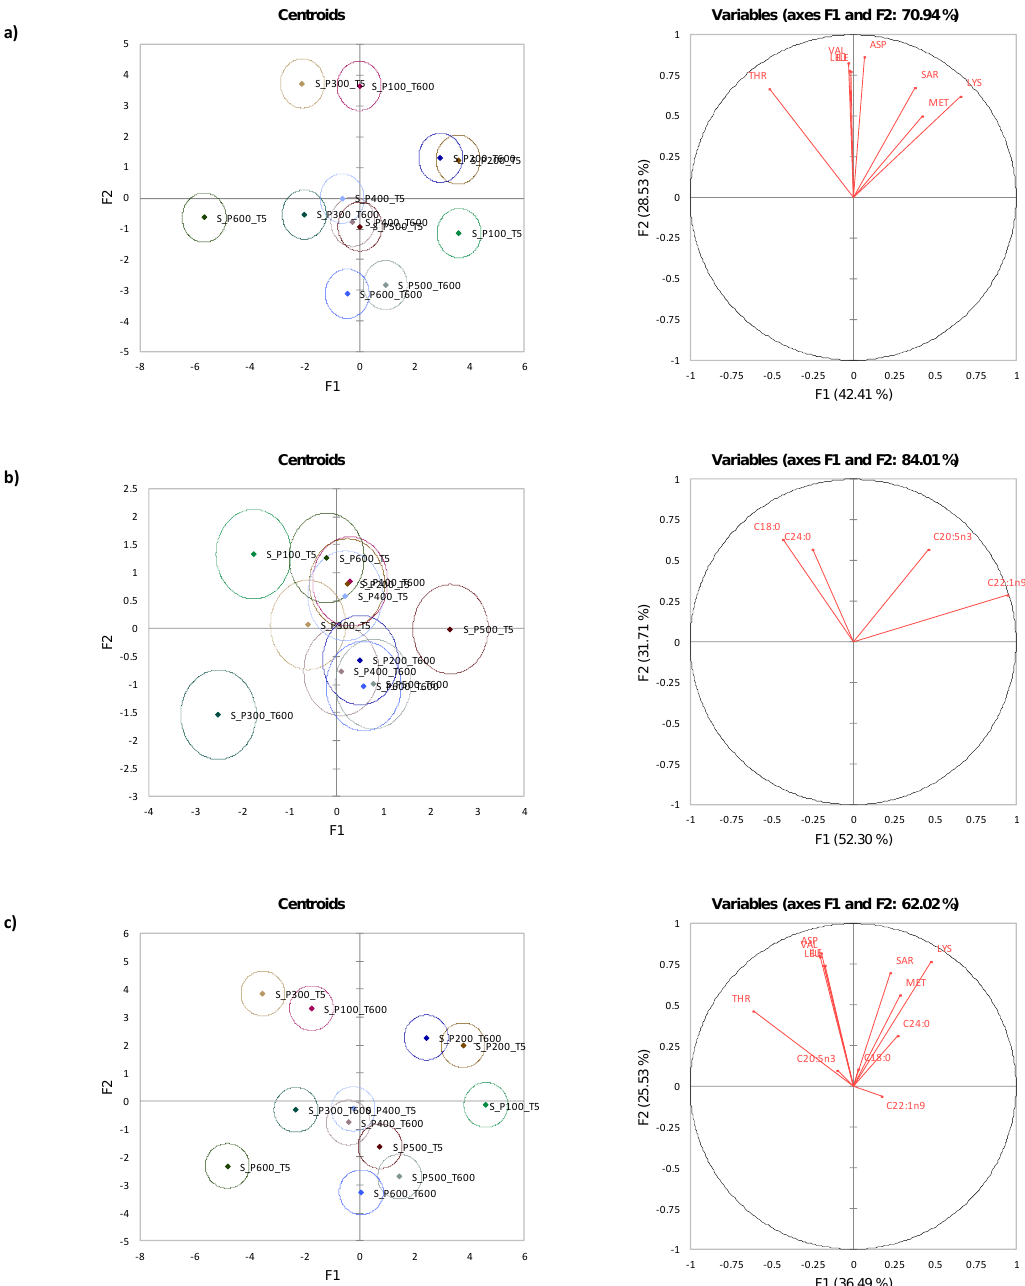
Similar to the Diamond Shell clam results, CVA plots indicated that amino acids (Figure 3a) discriminated the HPP processed samples better compared to fatty acids (Figure 3b). Figure 3c showed that the merged results for both amino and fatty acids, further enhanced discrimination between samples with HPP processing in terms of both fatty acid and amino acid data.